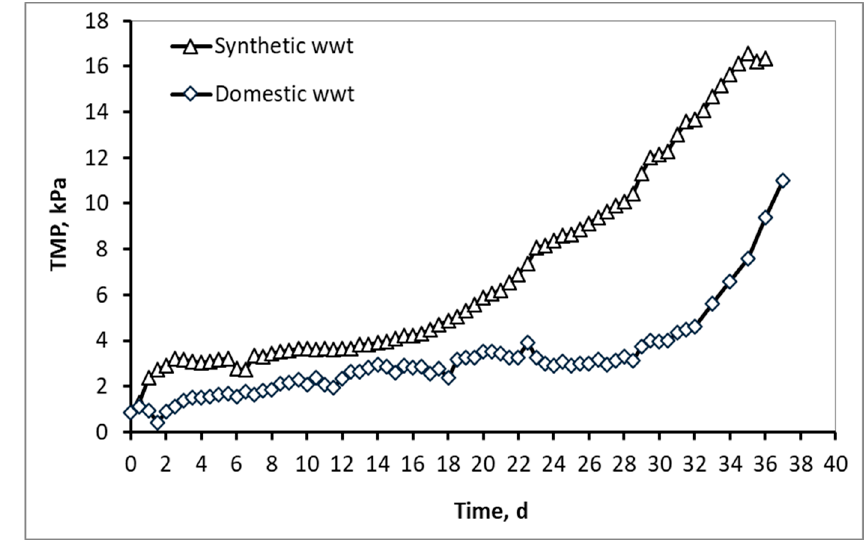
Figure 7. Typical TMP graphs as a function of MBR operation time for synthetic versus domestic wastewater. Flux for synthetic wwt = 16.4 Lmh, flux for domestic wwt = 20.9 Lmh. For both MBRs temperature = 24 ± 2 °C and D O in both ATs =2.5 ± 0.5 mg/L.